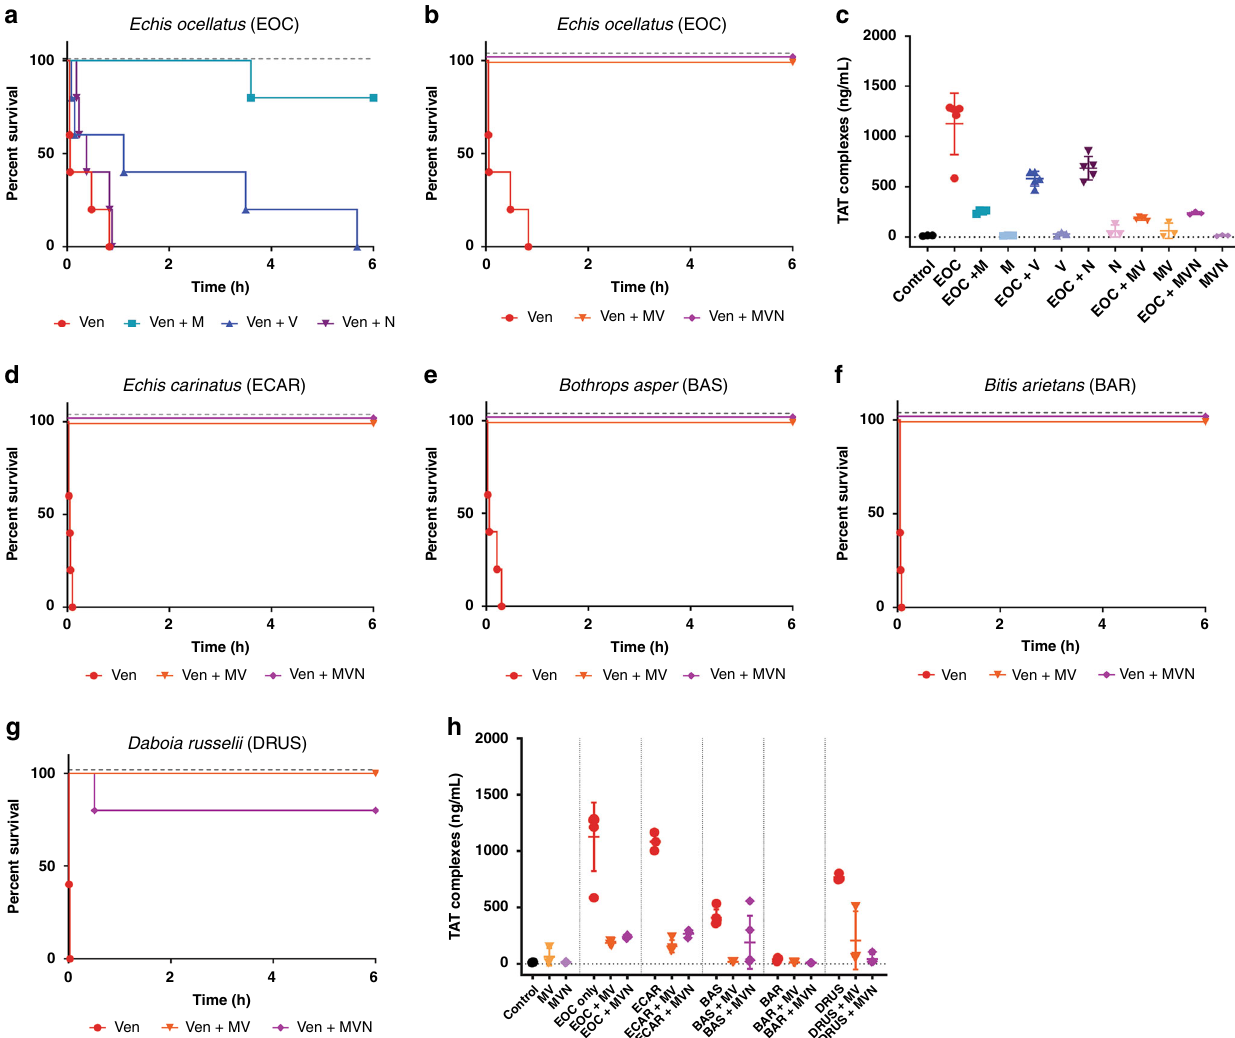
Fig. 5 Combinations of small molecule toxin inhibitors broadly protect against venom lethality in an in vivo ‘ preincubation ’ model of snake envenoming. Kaplan – Meier survival graphs for experimental animals ( n = 5) receiving venom (Ven) preincubated (30 min at 37 °C) with different small molecule inhibitors or inhibitor mixes via the intravenous route and monitored for 6 h. Drug-only controls are presented as black dashed lines at the top of each graph (none of the drugs exhibited any observable toxicity at the given doses). a Survival of mice receiving 45 µ g of E. ocellatus venom (2.5 × LD 50 dose) with and without 60 µ g of marimastat or varespladib or nafamostat. b Survival of mice receiving 45 µ g of E. ocellatus venom (2.5 × LD 50 dose) with and without a dual combination mixture of marimastat and varespladib (MV, 60 µ g each) or a triple combination mixture of marimastat, varespladib and nafamostat (MVN, 60 µ g each). c Quanti fi ed thrombin-antithrombin (TAT) levels in the envenomed animals from ( a ) and ( b ). Where the time of death was the same within experimental groups (e.g., early deaths or complete survival) TAT levels were quanti fi ed for n = 3, and where times of death varied, n = 5. The data displayed represents means of the duplicate technical repeats plus SDs. d – g Kaplan – Meier survival graphs for experimental animals ( n = 5) receiving inhibitor mixes (MV or MVN) preincubated with 2.5 × LD 50 dose of E. carinatus (47.5 µ g, d ), B. asper (47 µ g, e ), B. arietans (54 µ g, f ) or D. russelii (20 µ g, g ) venom. h Quanti fi ed TAT levels in the envenomed animals from ( d ) to ( g ), with data presented as described for ( c ). Source data provided in Supplementary Data